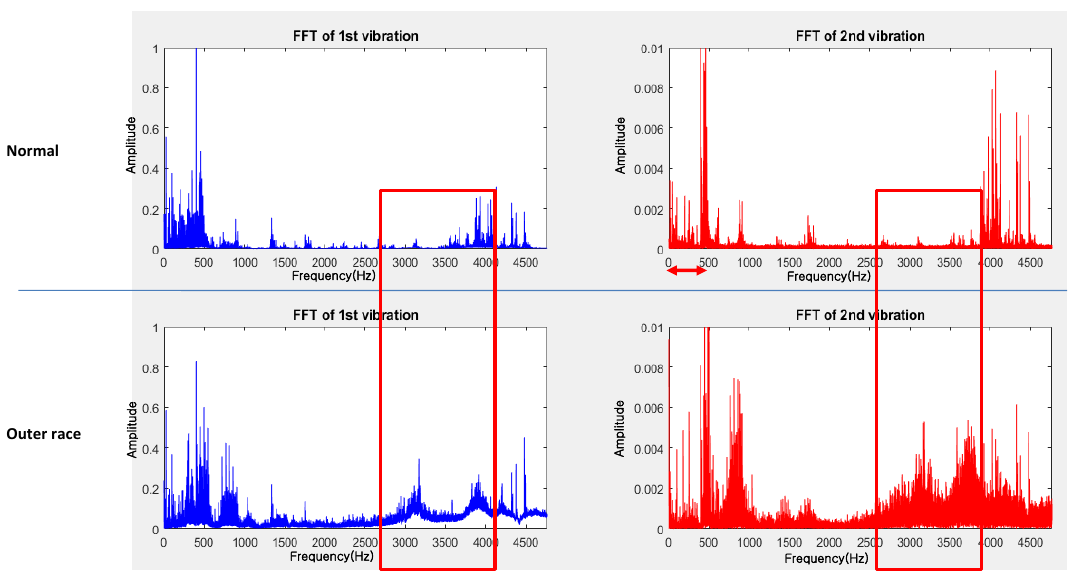
Figure 3. Spectral density difference in resonance